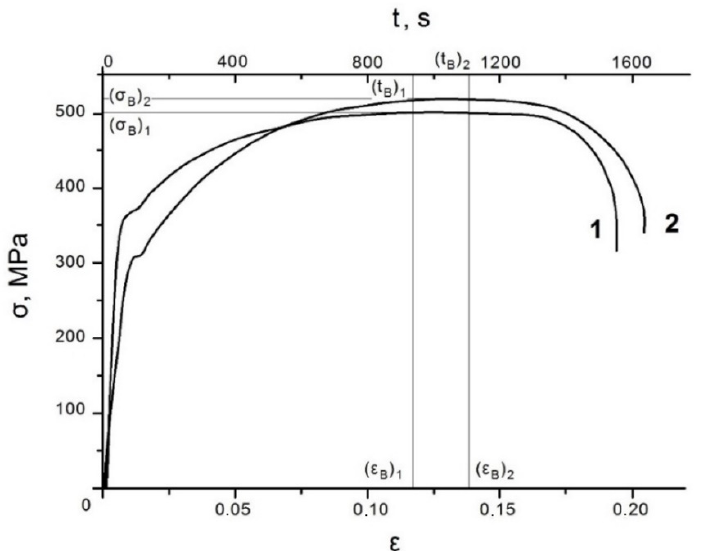
Figure 3. Loading diagrams of 0.12C-1Cr-1Mo-1V steel: 1—initial state; 2—after operation 260 thou- sand